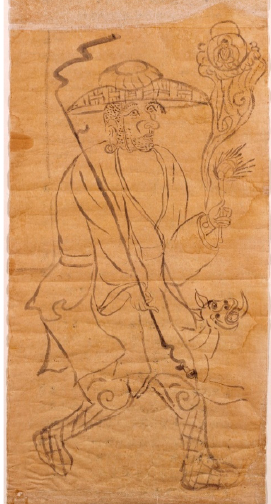
Figure 11. Itinerant monk on the reverse of the Lotus Sutra (detail). Dunhuang. Ink on paper, H. 26.1 cm. Bibliothèque nationale de France (Pelliot chinois 3075).